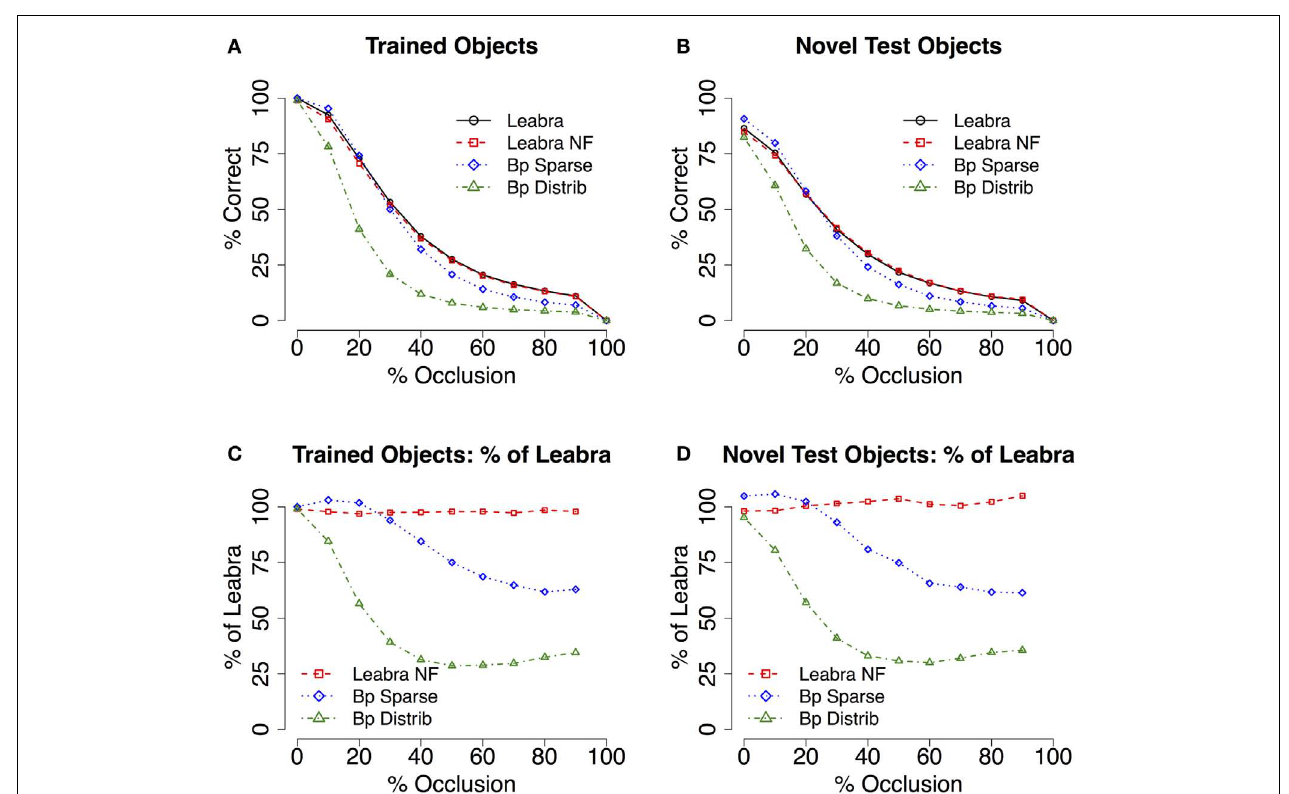
inhibitory processing that explains this robustness. ( B) Mean recognition for novel test objects, comparing between the same models as A.The advantage of Leabra’s recurrent connectivity is similarly apparent during generalization. ( C,D) Results as a percentage of the Leabra performance – the slope of the lines in A and B masks the substantial effect sizes present – For trained objects, Bp Sparse performs as low as 66% compared to Leabra, and Bp Distrib as low as 31%. Again, results were qualitatively similar for novel test